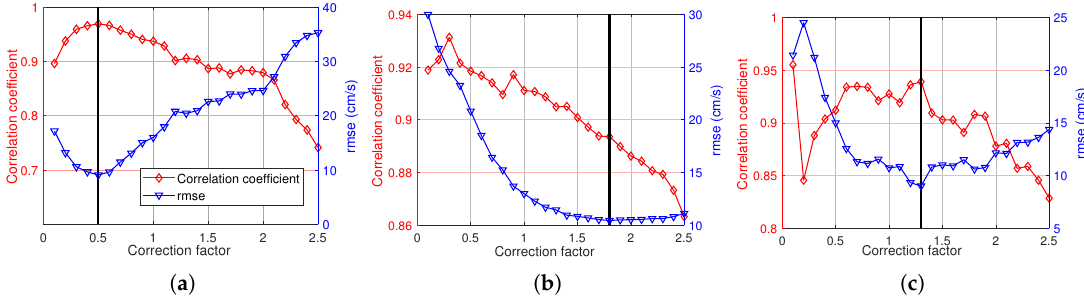
Figure 17. Correlation coefficient and root-mean-square error (rmse) of radar–buoy comparison vary with the correction factor. ( a ) DOSH–buoy comparison; ( b ) SHLI–buoy comparison at buoy A; ( c ) SHLI–buoy comparison at buoy B. The thick black vertical line indicates the correction factor yielding a minimum rmse value. For the DOSH experiment, the optimal correction factor estimated by TLSCR method is just the correction factor yielding the minimum rmse value. However, for SHLI experiment, the optimal correction factor only yields the minimum rmse at buoy B. The correction factor yielding the minimum rmse value for SHLI buoy A is equal to